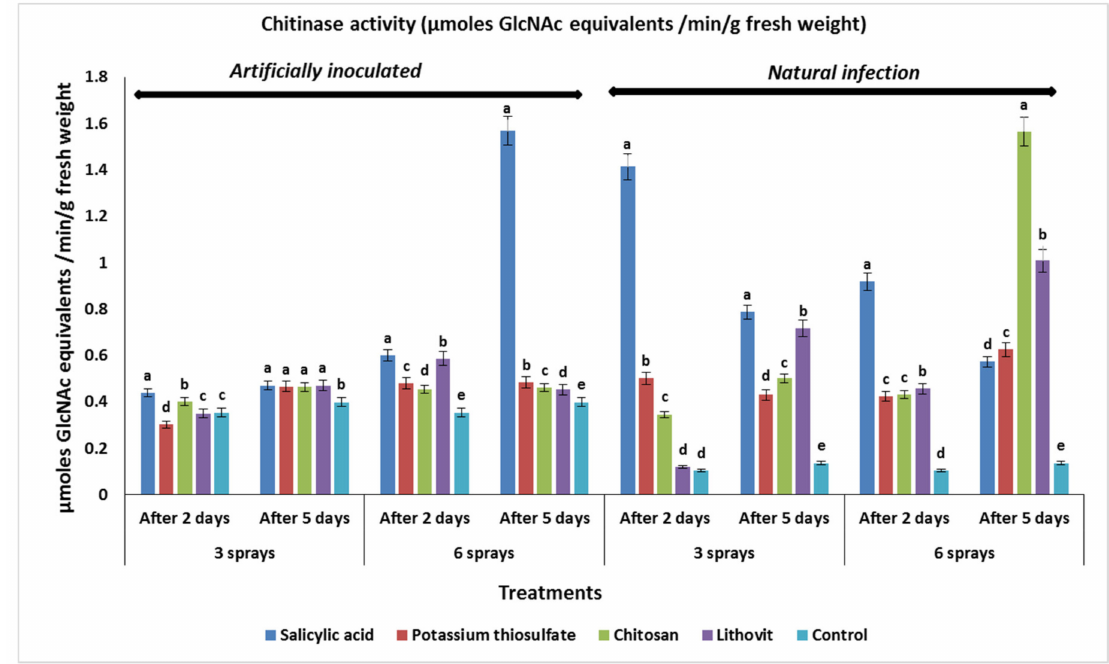
Figure 3. The e ff ect of the tested chemicals as pre-harvest foliar application at 3 and 6 sprays on chitinase activity in the treated tomato fruits, naturally and artificially infected with A. alternata , at di ff erent periods of incubation (after two or five days) (as µ moles GlcNAc equivalents / min / g fresh weight). Within each incubation period (after two or five days), the same letters indicate no significant di ff erence among the treatments at ( p <